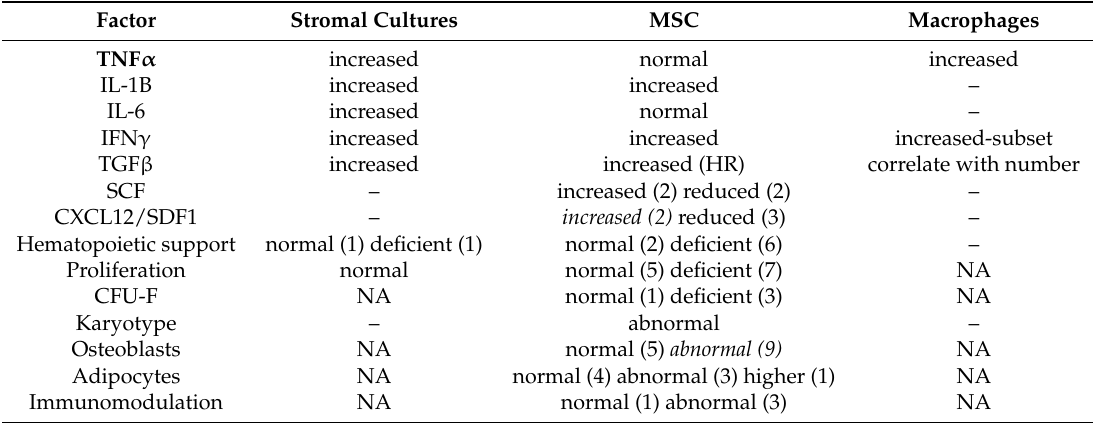
Table 1. Summary of in vitro , murine in vivo , and human in situ data on MDS microenvironment. Factor Stromal Cultures MSC Macrophages TNF α increased normal increased IL-1B increased increased – IL-6 increased normal – IFN γ increased increased increased-subset TGF β increased increased (HR) correlate with number SCF – increased (2) reduced (2) – CXCL12/SDF1 – increased (2) reduced (3) – Hematopoietic support normal (1) deficient (1) normal (2) deficient (6) – Proliferation normal normal (5) deficient (7) NA CFU-F NA normal (1) deficient (3) NA Karyotype – abnormal – Osteoblasts NA normal (5) abnormal (9) NA